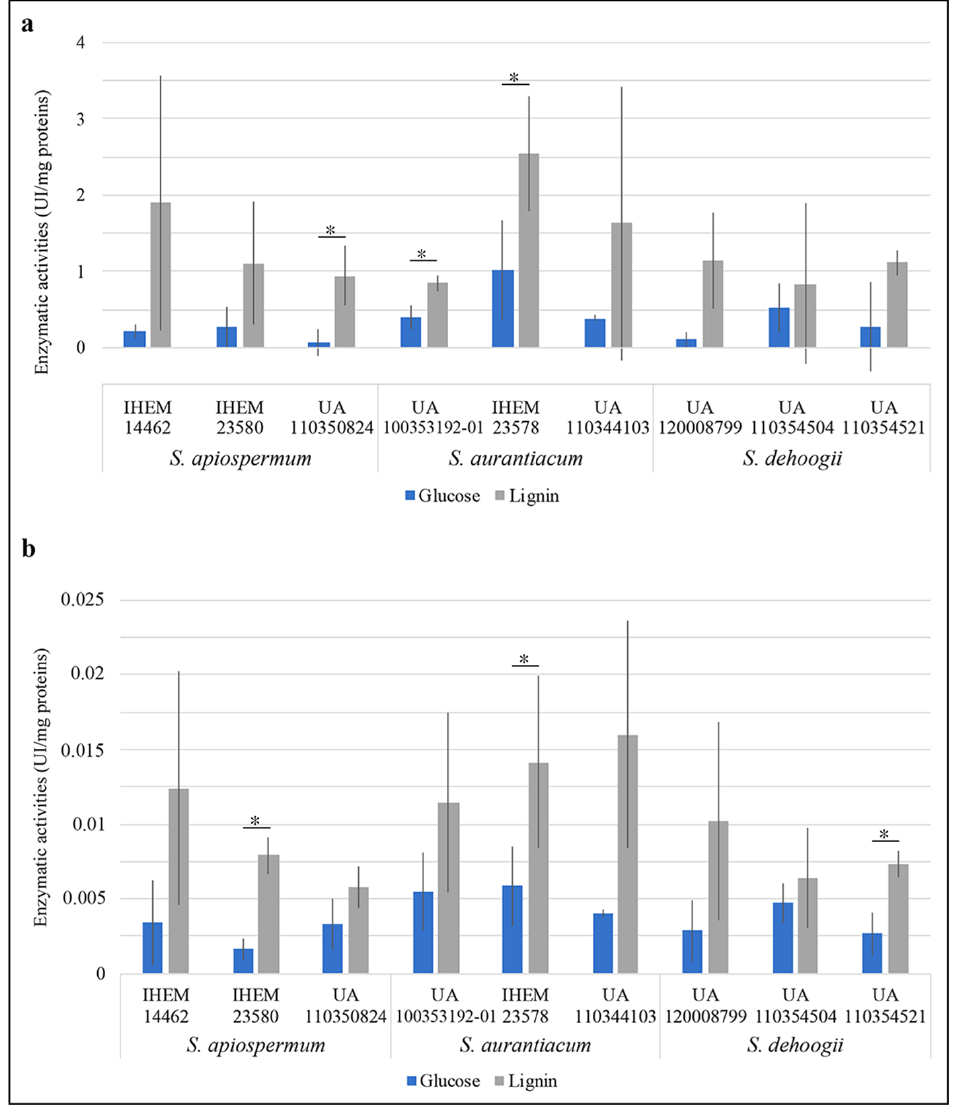
Figure 2. ( a ) Peroxidase and ( b ) oxidase activities (UI/mg proteins) of culture supernatants collected after 24 h of incubation. For each enzymatic assay, three independent experiments were realized and all reactions were carried out in duplicate. According to the data distribution, statistical analysis was performed using a Student’s t -test or Mann–Whitney test, * p -value < 0.05. Similar expression patterns were obtained for S. apiospermum and S. dehoogii (Figure 4). All peroxidase genes, except SAPIO_CDS10447, were overexpressed compared to control conditions suggesting direct or indirect involvement in lignin degradation. In S. aurantiacum , only two of these genes (SAPIO_CDS4198 and SAPIO_CDS10583) were overexpressed. Considering the MCO superfamily, only SAPIO_CDS8659 was overexpressed in all species. Three other genes were also overexpressed but only in two species S. apiospermum and S. de- hoogii : SAPIO_CDS2438, SAPIO_CDS0314 and SAPIO_CDS4646. Finally, SAPIO_CDS10367 was overexpressed only in S. dehoogii